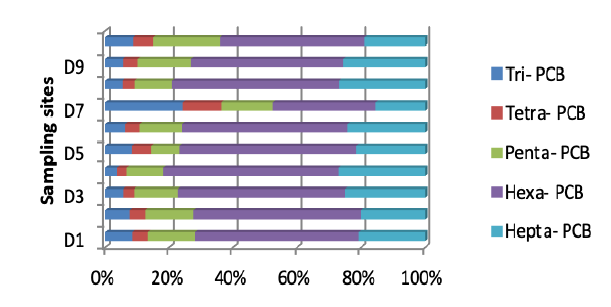
Figure 3. Composition of PCBs in sediment samples according to the number of substituted chlorine